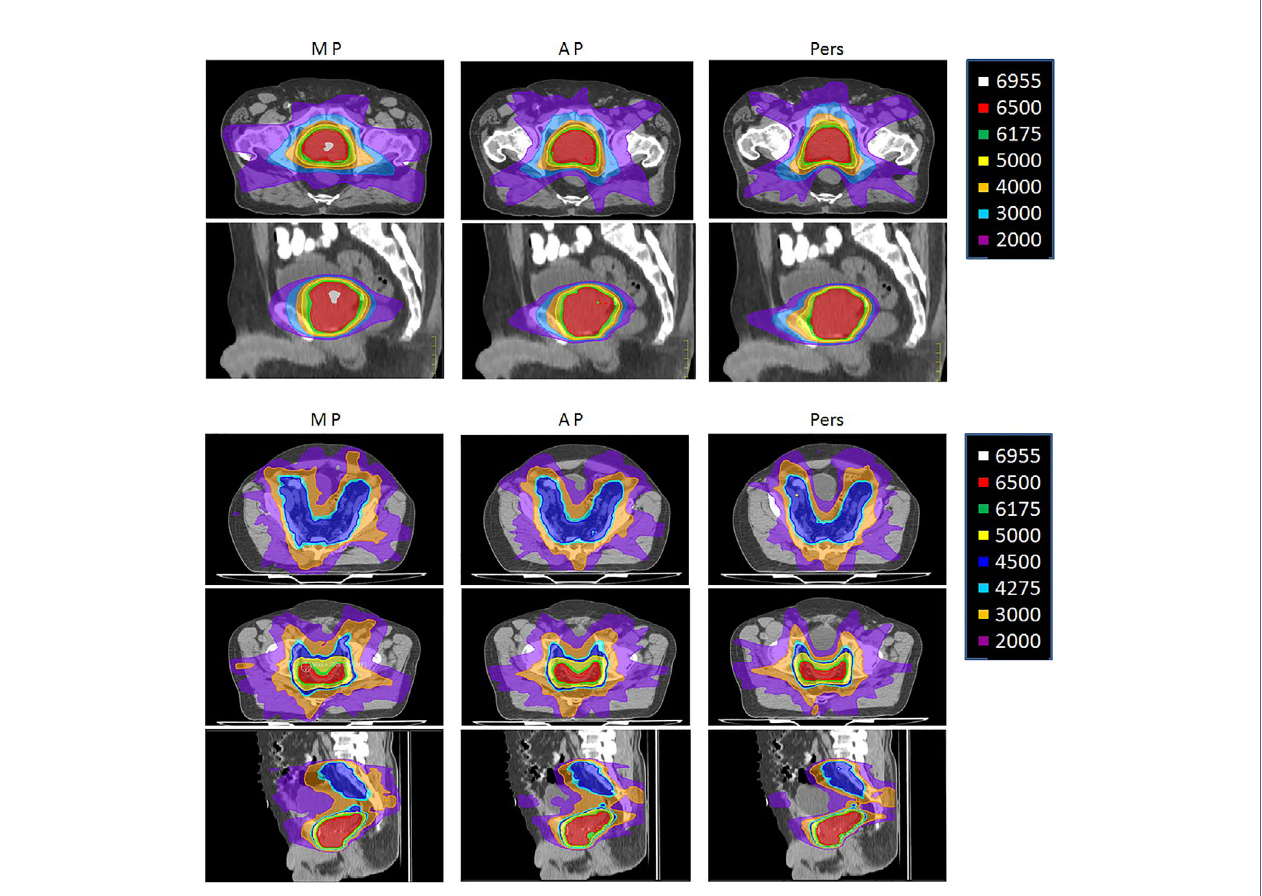
FIGURE 3 | Representative dose distributions for manual plans (MP), Autoplanning (AP), and Personalized plans (Pers) for (upper) low-risk and (lower) a high-risk prostate cancer